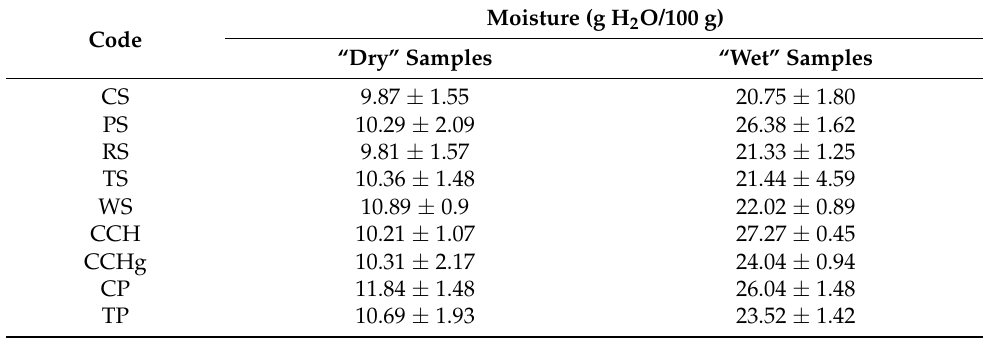
Table 7. Moisture content of starch